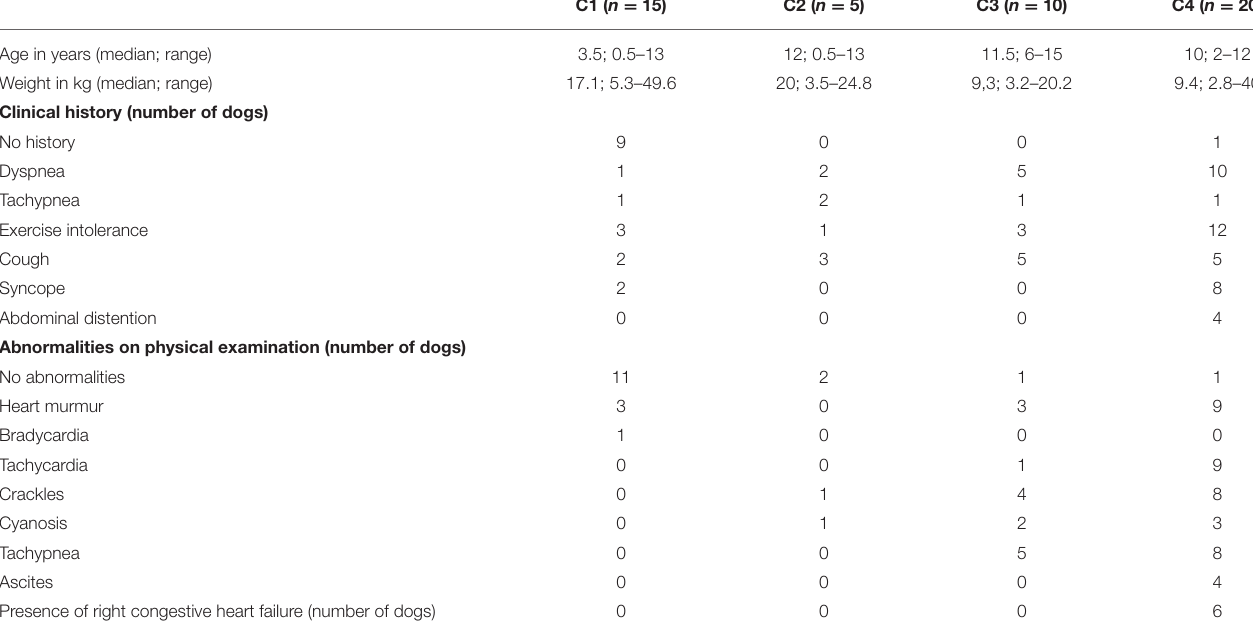
TABLE 2 | Summary of age, weight, clinical history, abnormalities on physical examination, and tricuspid regurgitation pressure gradient after echocardiography.